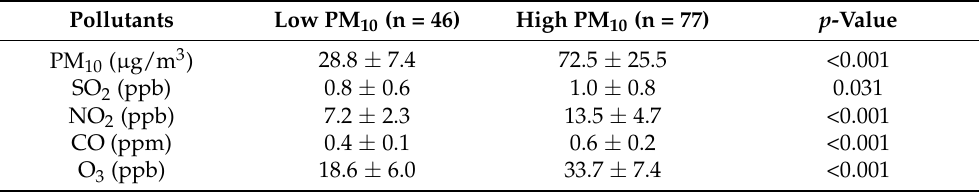
Table 4. Pollutant data between high-PM 10 period ( ≥ 45 µ g/m 3 ) and low-PM 10 periods (<45 µ g/m 3 ) recommended by WHO air quality guidelines 2021.